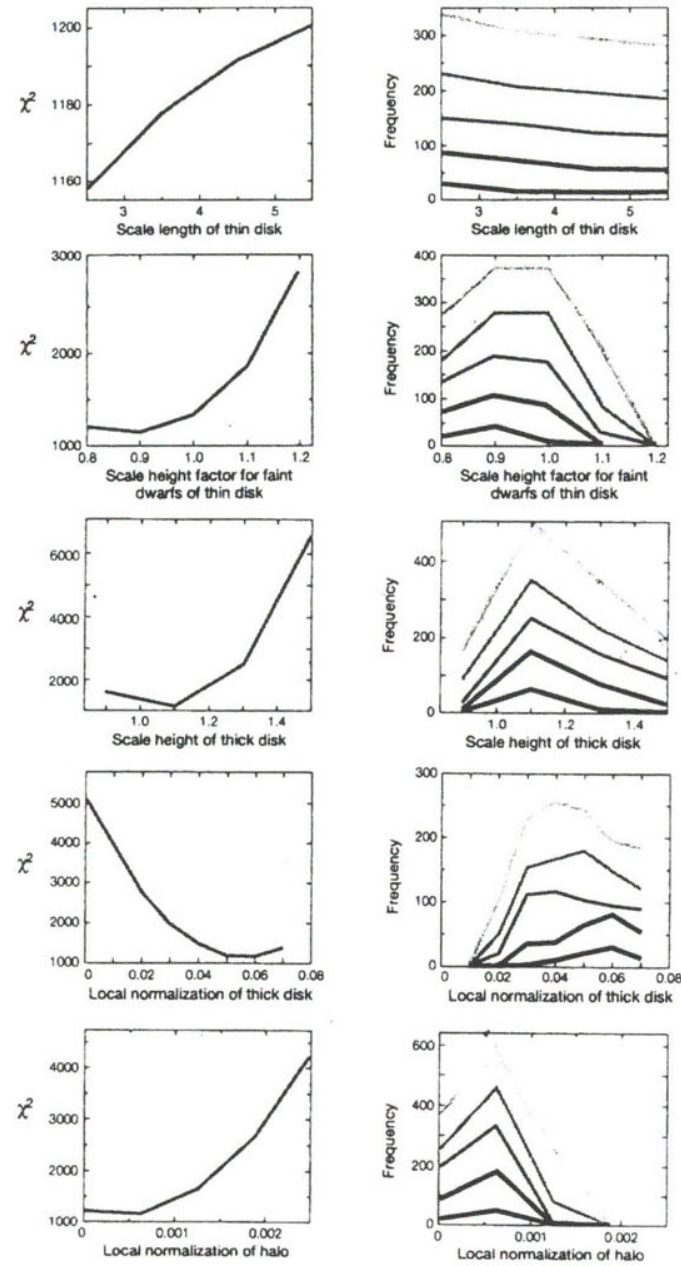
Fig. 8. x 2 curves (left) and frequency distributions (right) for some of the principal